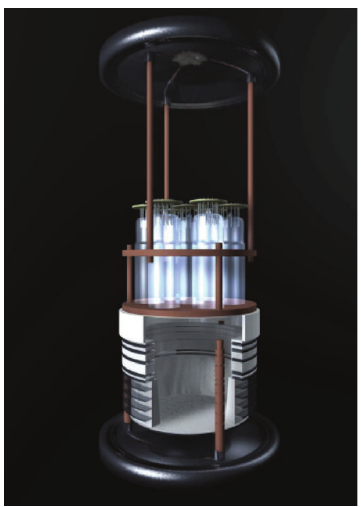
Figure 3: 3D layout of the 2.3 l prototype, configuration for LNGS physics run. Details in